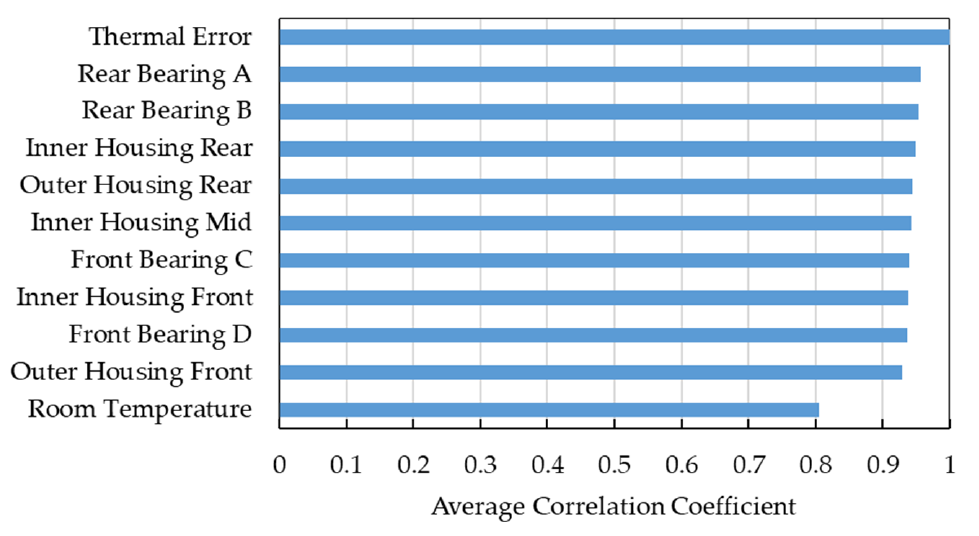
Figure 11. The visualization of the average correlation coefficients between the feature temperature points and the thermal error.